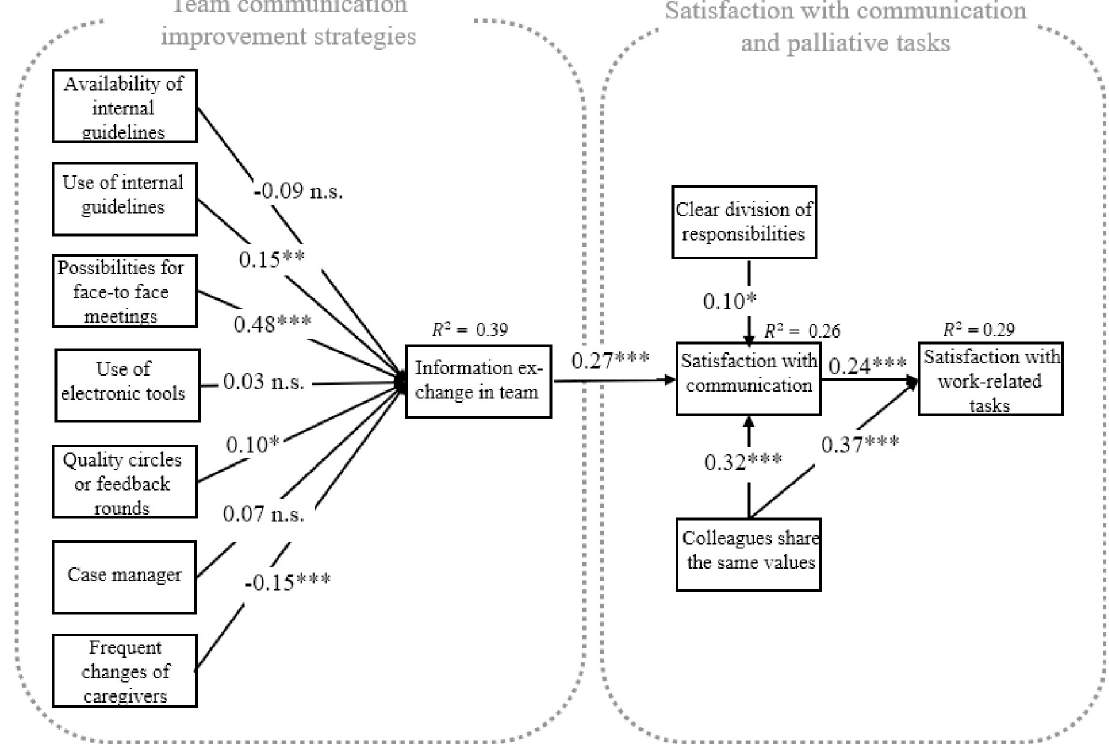
Fig 2. Empirical model. � indicates p < 0.05 �� indicates p < 0.01 ��� indicates p < 0.005. Standardized effects are given. All effects are controlled for position (lead/no lead), type of caregiver (context), place of work (city vs. countryside), function (job description), additional training, and gender; n =